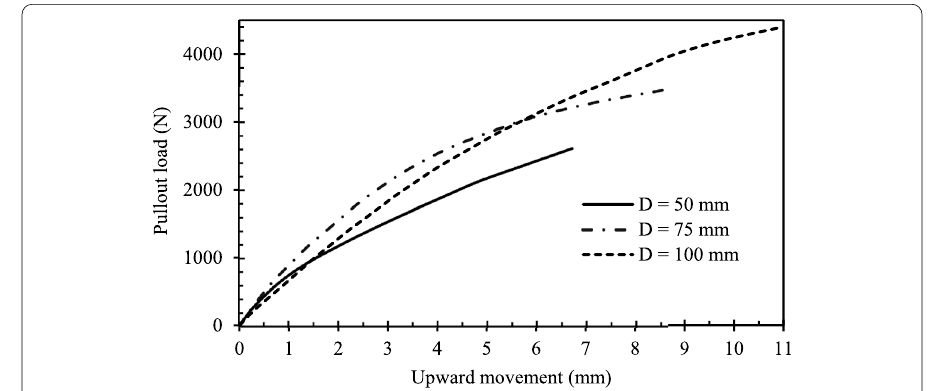
Fig. 8 Pullout behaviour of constant length GPA ( L